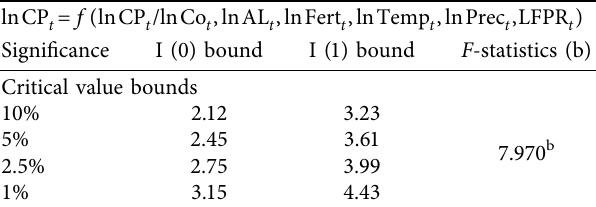
Table 4: ARDL bounds test results.